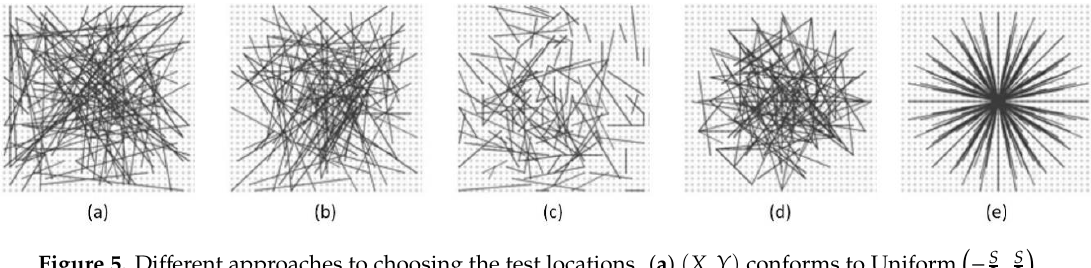
Figure 5. Di ff erent approaches to choosing the test locations. ( a ) ( X , Y ) conforms to Uniform Figure 5. Different approaches to choosing the test locations. ( a ) (𝑋, 𝑌) conforms to Uniform (− 𝑆 (cid:16) (cid:17) S 2 0, 1 ( b ) ( X , Y ) conforms to Gaussian , ( c ) X conforms to Gaussian 25 𝑆 2 ) , ( c ) 𝑋 conforms to Gaussian (0, 1 ( b ) (𝑋,𝑌) conforms to Gaussian (0, 1 (cid:16) (cid:17) 25 x i , 1 S 2 Gaussian , ( d ) The ( x i , y i ) are randomly sampled from discrete locations of a coarse polar 100 𝑆 2 ) , ( d ) The (𝑥 𝑖 , 𝑦 𝑖 ) are randomly sampled from discrete locations of a coarse polar Gaussian (𝑥 𝑖 , 1